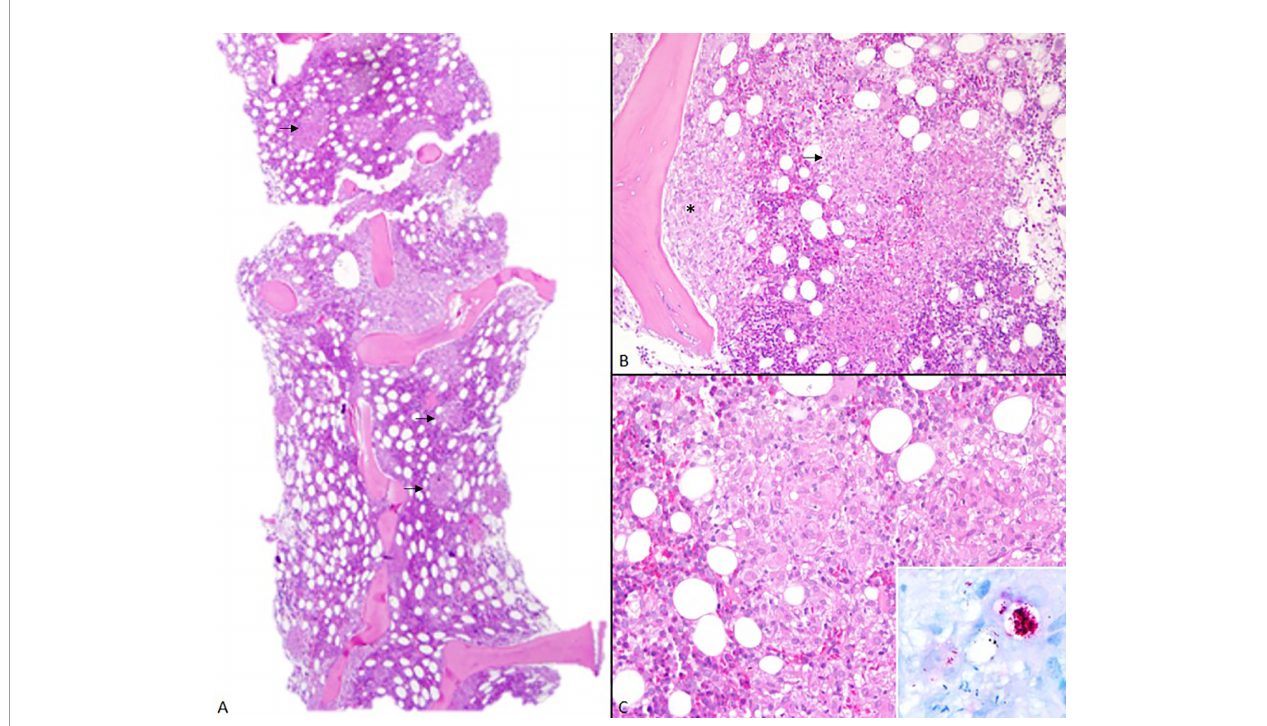
FIGURE 1 | Bone marrow. (A) At low power, bone marrow microscopic examination shows hypercellularity in nodular pattern (arrows) (H&E, 2x). (B) Noncaseating epithelioid granulomas in interstitial (arrow) and paratrabecular loci (*) (H&E, 10x). (C) These granulomas are composed mostly of epithelioid macrophages and a few dispersed lymphocytes (20x, H&E). In detail, macrophages are enlarged by large collections of leprosy bacilli – globi (100x, Faraco-Fite).